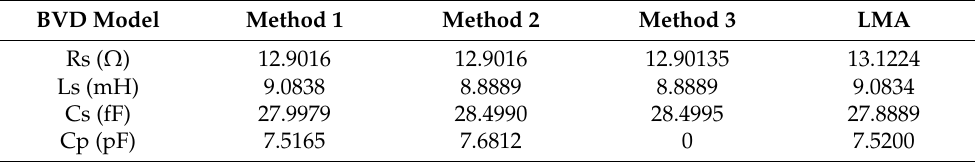
Table 1. BVD model parameters for QCM sensor depending on the computation